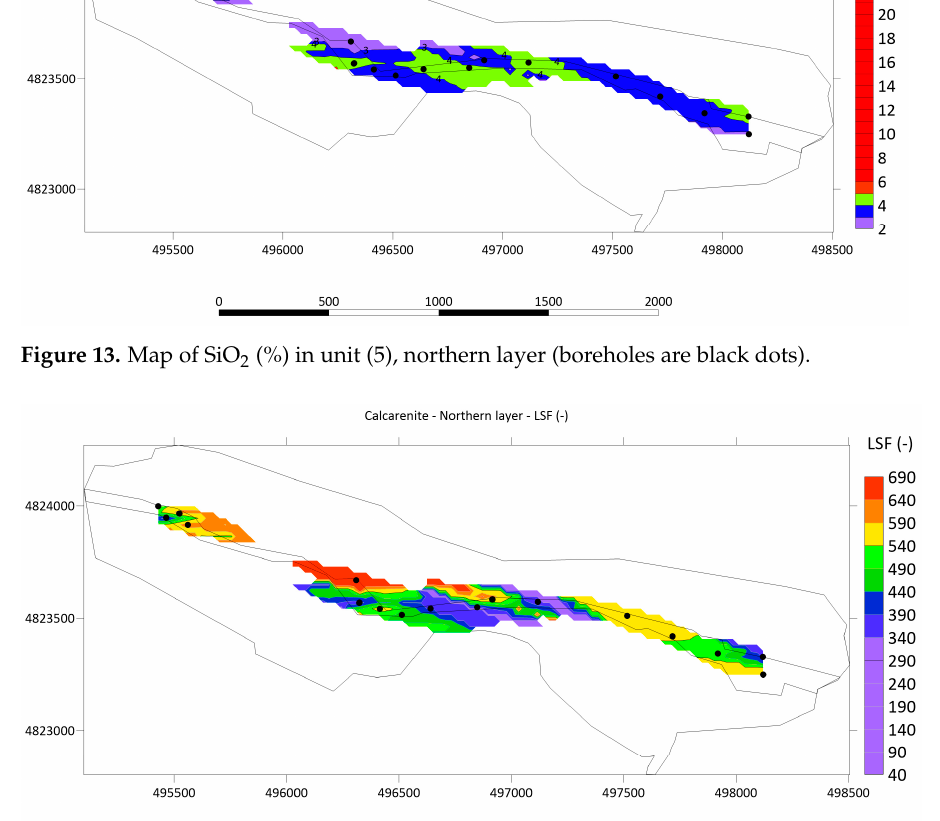
Figure 14 . Map of LSF ( − ) in unit (5), northern layer (boreholes are black dots). The last three maps were interpolated for unit (7), in the western layer. Interpolation for CaO (%), SiO 2 (%) and LSF ( − ) was carried out using IDW. Power exponent was 2, searching circle 335 m, and anisotropy = 1 (no anisotropy). The maps are given in Figures 15–17.